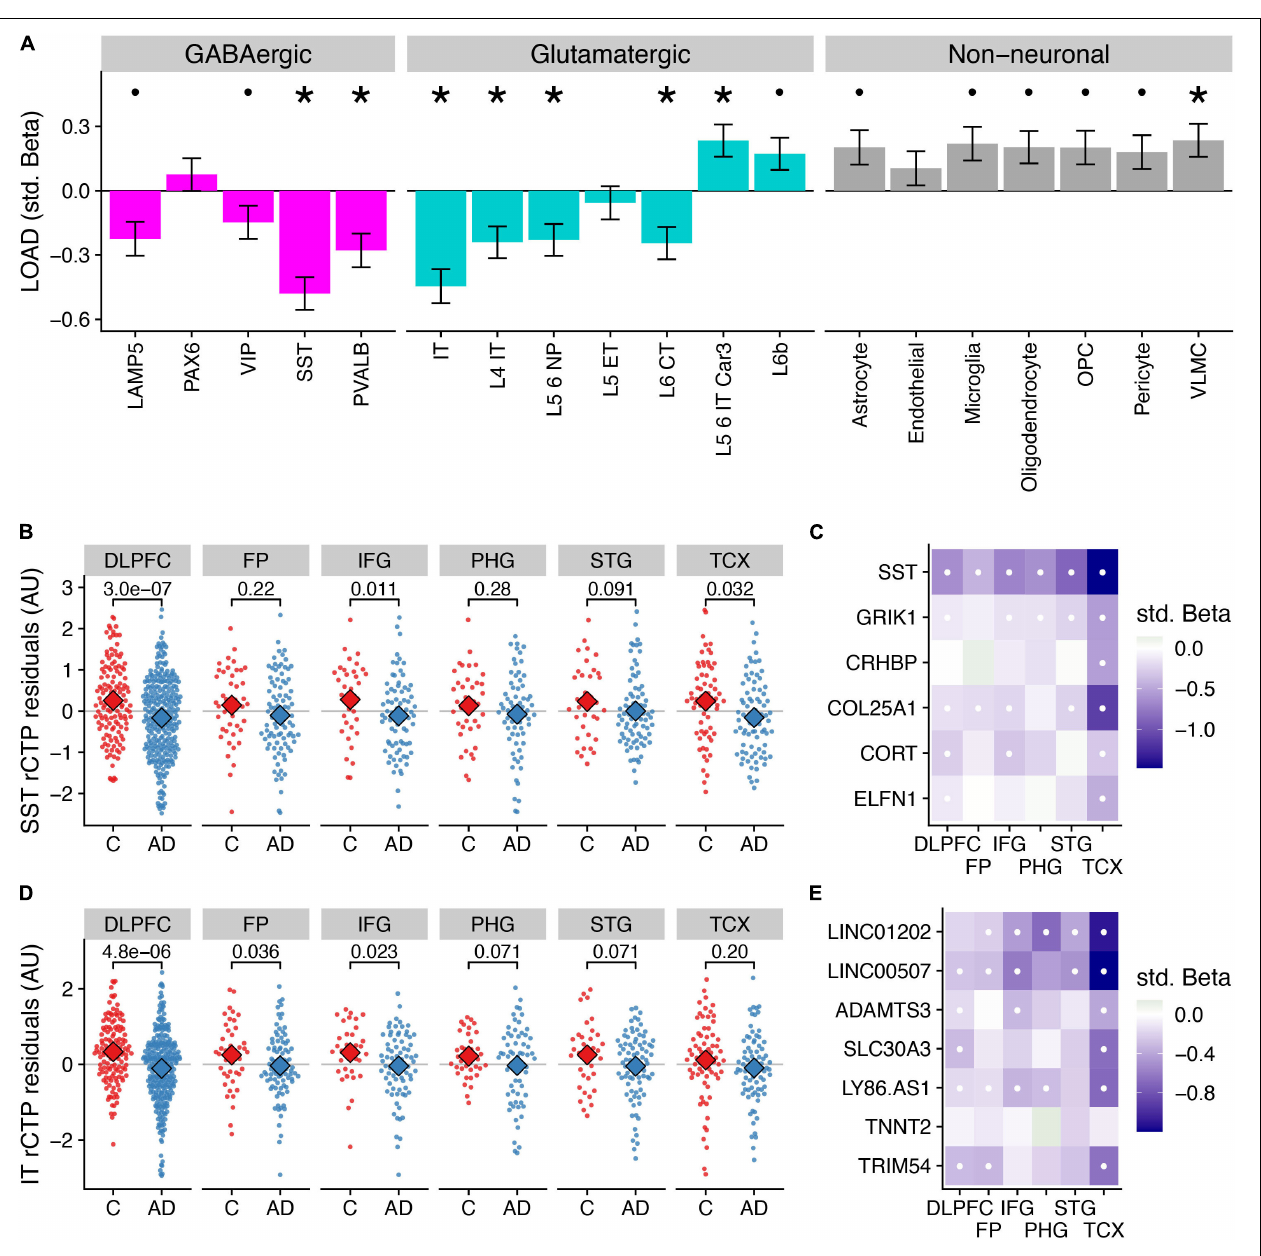
FIGURE 1 | Differences in relative cell type proportions of neuronal and non-neuronal subclasses in Alzheimer’s disease. (A) Consensus associations of Alzheimer’s disease (“AD”) vs. control (“C”) status and cell type-specific relative cell type proportions (rCTPs) across six bulk RNAseq datasets. Y-axis shows standardized beta coefficients estimated using a mixed effects model to pool associations across datasets. Positive (negative) standardized beta coefficients indicate an increase (decrease) in the cell type-specific rCTP in AD. Error bars indicate one standard deviation. Asterisks (dots) above each cell type indicate two-sided p bonf < 0.05 (or less stringent FDR < 0.1). (B) Comparisons between rCTPs between controls and AD cases in each of the six bulk gene expression datasets, ROS/MAP, sampling the dorsolateral prefrontal cortex (DLPFC), MSSB, sampling the Frontal Pole (FP), Inferior Frontal Gyrus (IFG), Parahippocampal Gyrus (PHG), and Superior Temporal Gyrus (STG), and the Mayo cohort, sampling the Temporal Cortex (TCX). Y-axis shows estimates of rCTPs for somatostatin (SST) interneurons from individual post-mortem samples (each dot reflects one individual), after covarying for age and sex. Numbers show p -values from a statistical model comparing residualized rCTPs between controls and AD cases, uncorrected for multiple comparisons across datasets and cell types. Subjects with outlier values of rCTPs not shown. (C) Heatmaps showing AD case/control associations for marker genes for SST inhibitory cells. White dots indicate specific associations where FDR < 0.1. (D,E) Same as panels (B,C) for intra-telencephalic-projecting (IT) excitatory pyramidal cells (IT cells).